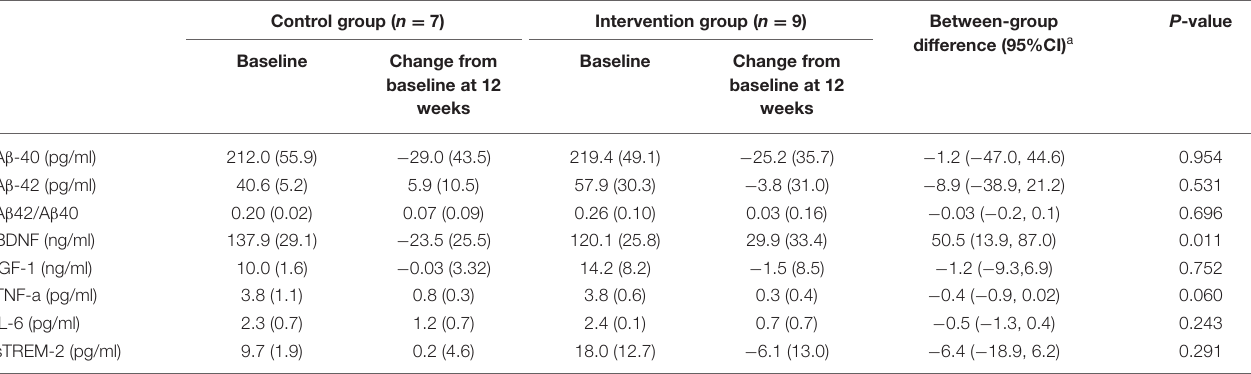
TABLE 5 | Adjusted comparison of neurobiological measurements between changes from baseline at 12 weeks after intervention in patients with mild AD ( n = 16). P -value Control group ( n = 7) Intervention group ( n = 9) Between-group difference (95%CI) a Baseline Change from Baseline Change from baseline at 12 baseline at 12 weeks